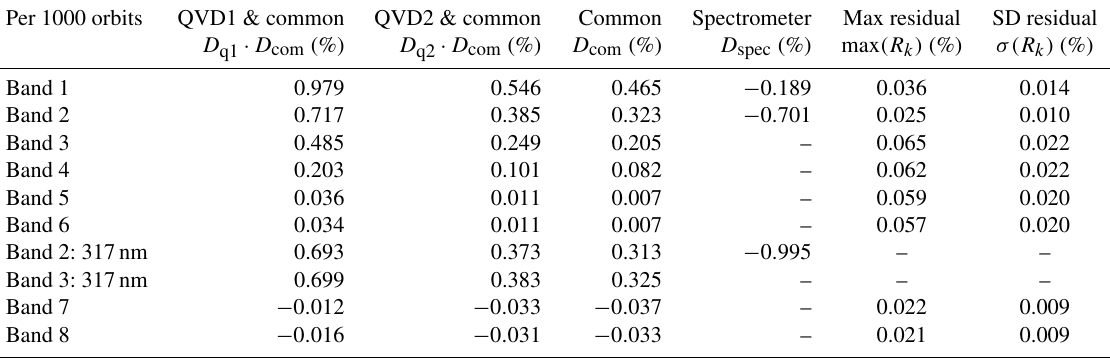
Table 4. The mean degradation per 1000 orbits as determined up to orbit 9748. Shown is the modelled degradation of the QVD1 ( D q1 ) and the QVD2 ( D q2 ), together with their common degradation D com . Moreover, in the UV spectrometer a spectral ageing component D spec of up to 1% per 1000 orbits reverses the apparent degradation. The maximum and standard deviation of the residuals max (R k ) and σ(R k ) observed with the UV (and SWIR) spectrometer are consistently lower than those observed with the UVIS and NIR spectrometers. The modelled degradation for the NIR and SWIR spectral ranges is on the order of the maximum residual value. The values for the SWIR spectral range have not been implemented in an L1b correction. Per 1000 orbits QVD1 & common QVD2 & common Common Spectrometer Max